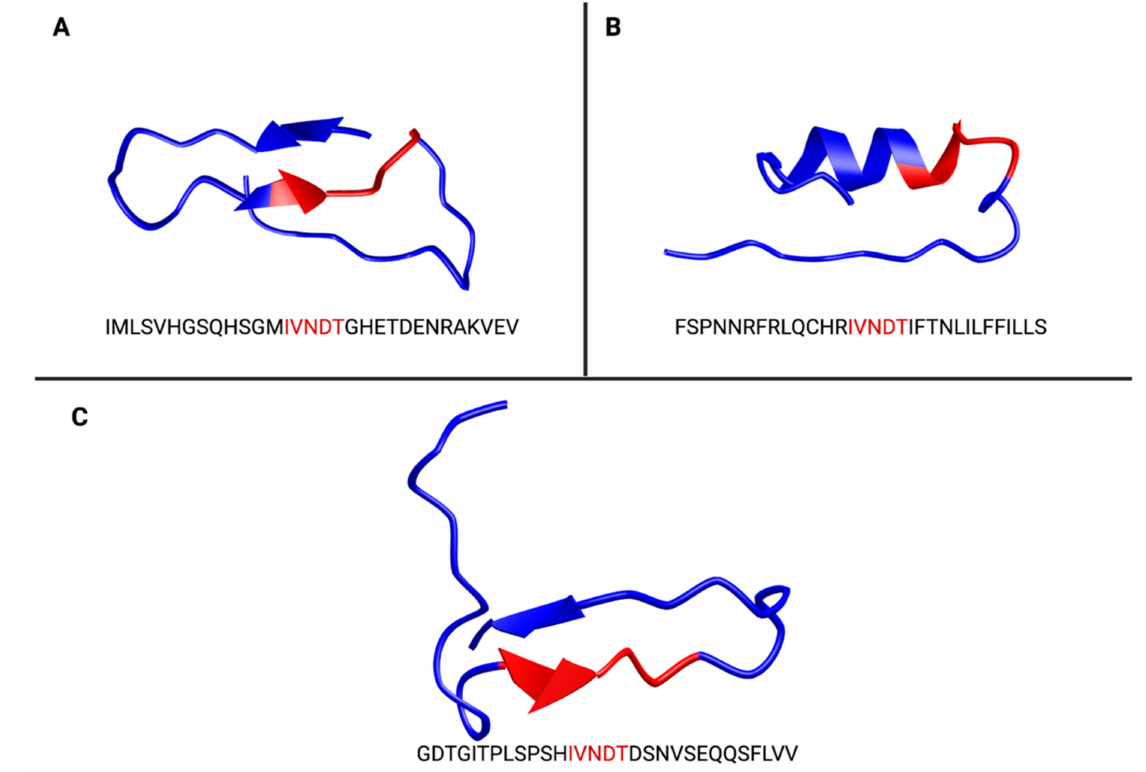
Figure 2. Predicted folding of epitope containing IVNDT (in red). ZIKV Asian lineage ( A ), VDDC alpha 1C ( B ) and HSP70 12 A ( C ). Prediction of peptide folding was done using PEP-FOLD3. HSP70 12A folding seems to be close to ZIKV E glycan loop folding, conversely to VDDC alpha